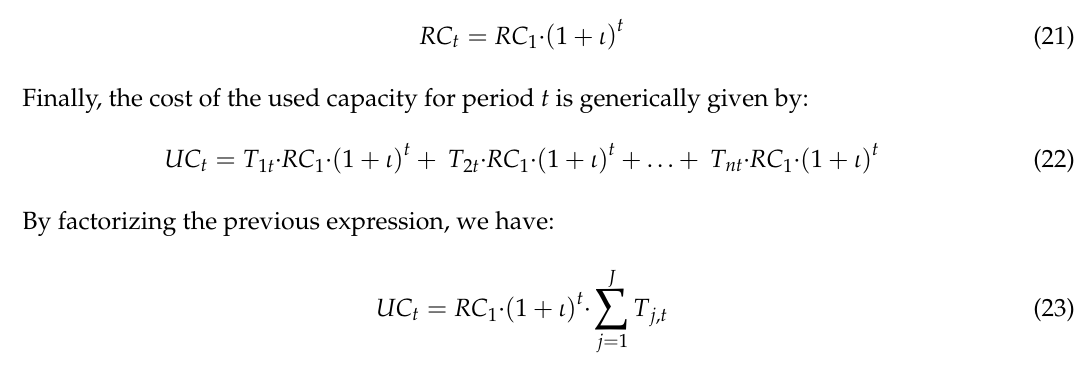
Table 1. Activity list and its duration.